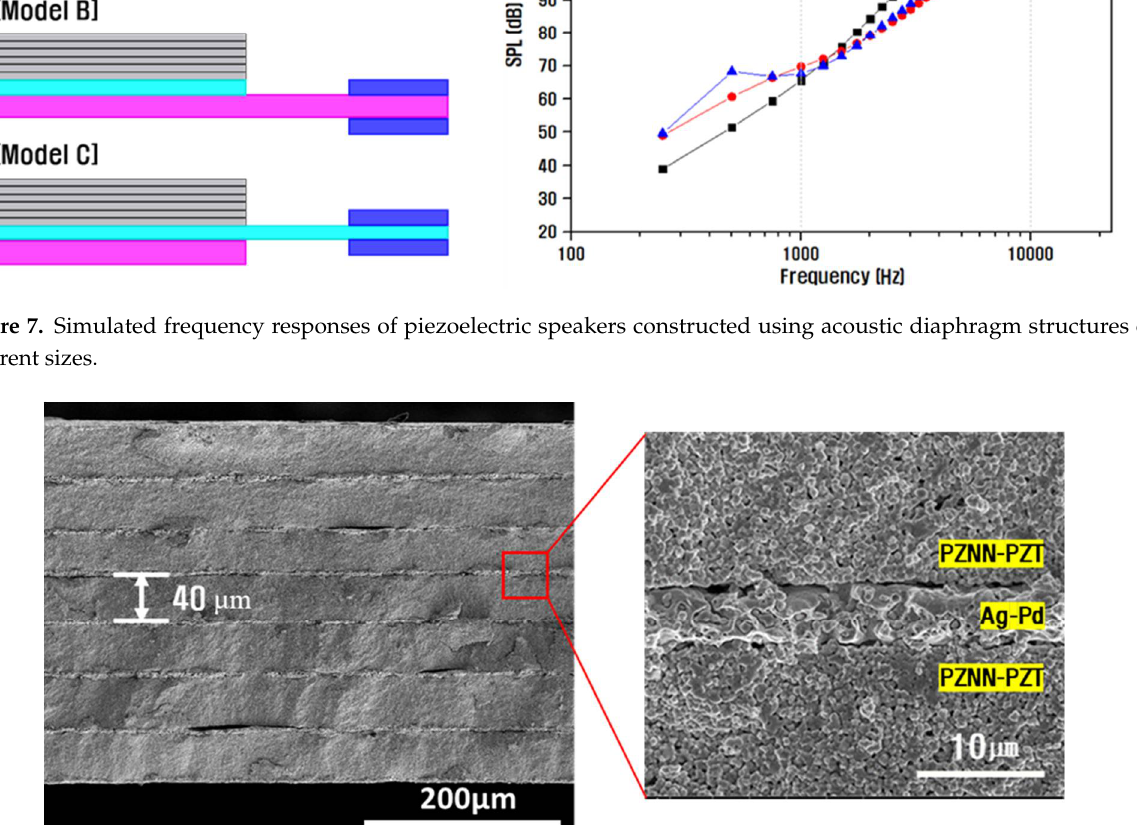
Figure 8. SEM images of the fractured surface of the co-fired multilayer PZNN-PZT/Ag–Pd